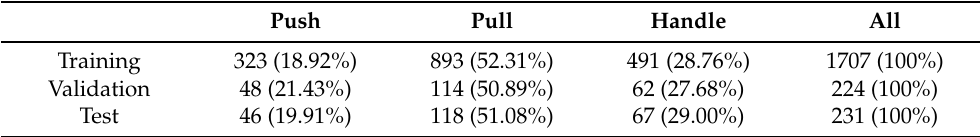
Table 3. Distribution of images per class for each partition for images with human demonstration. Push Pull Handle